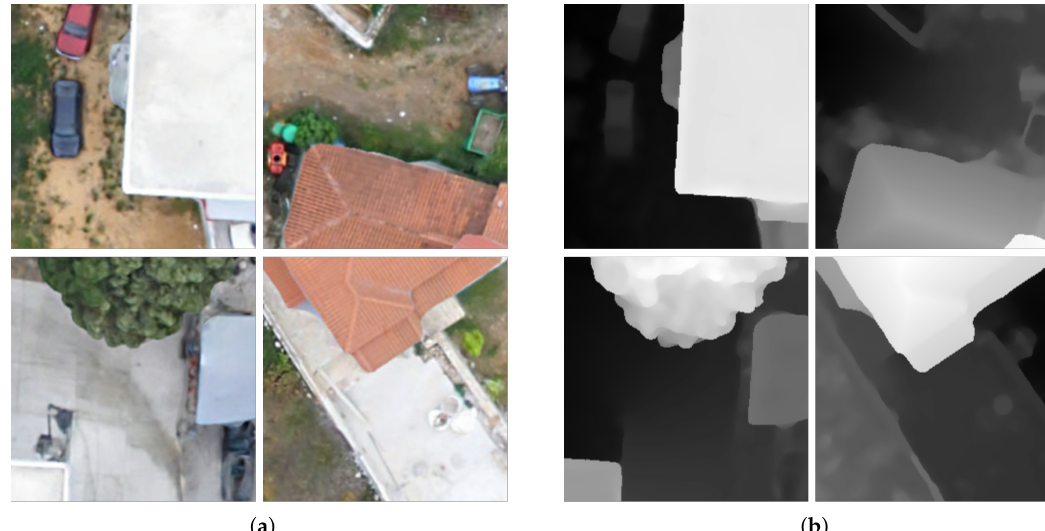
Figure 7. Rural dataset: Example ( a ) drone images and ( b ) DEM tiles taken over a Greek village. The target distribution is completely different compared to the satellite DEMs, but similar to the urban one (Figure